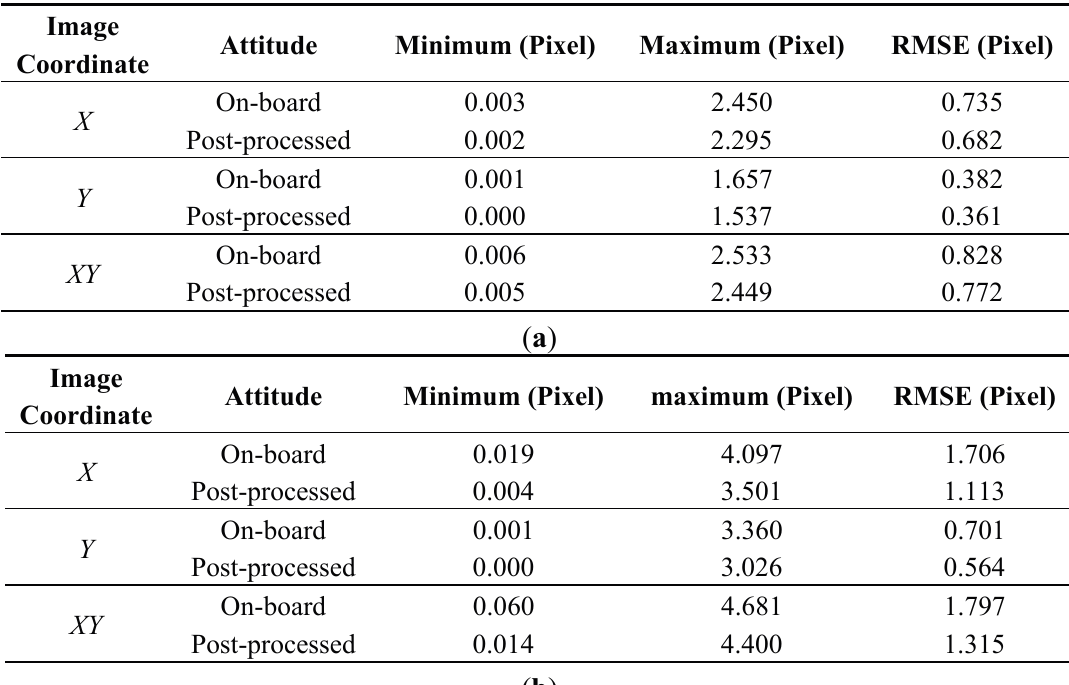
Table 5. Image of the point residual statistics of the tie points after free net adjustment. ( a ) Image point residual statistics of the Taihang image(the 457th track); ( b ) Image point residual statistics of the Tianjin image(the 785th